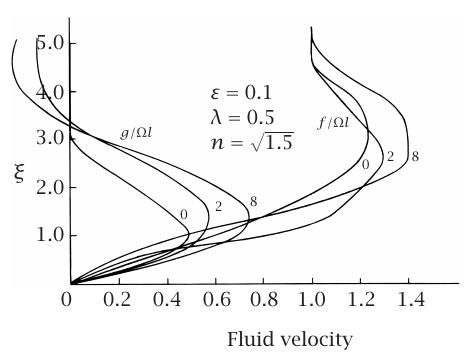
Figure 3.10 . Variations of f/ Ω l and g/ Ω l for different values of A , the mag- nitude of fluctuations in blowing velocity.